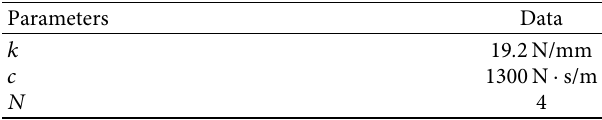
Table 2: Parameters of the relaxation-type damper.